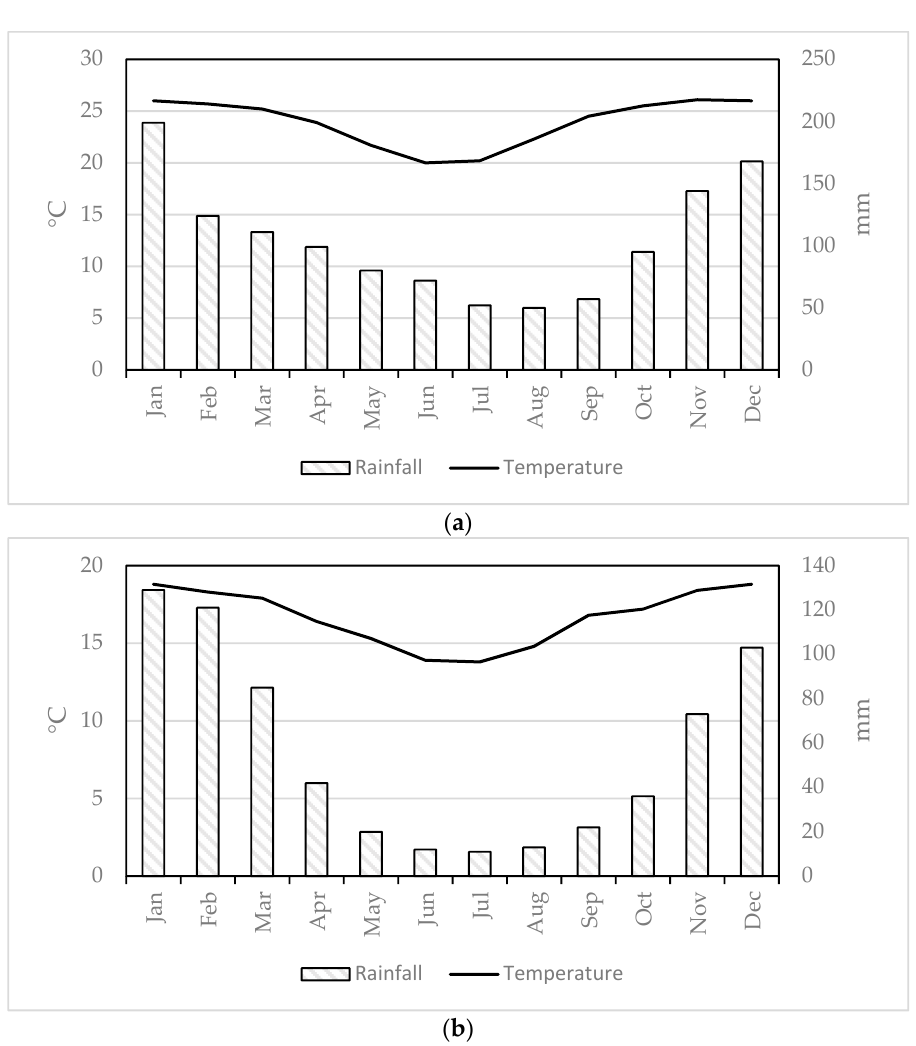
Figure 2. Climatology of the Pirai River watershed: ( a ) Downstream area; ( b ) Upstream area.